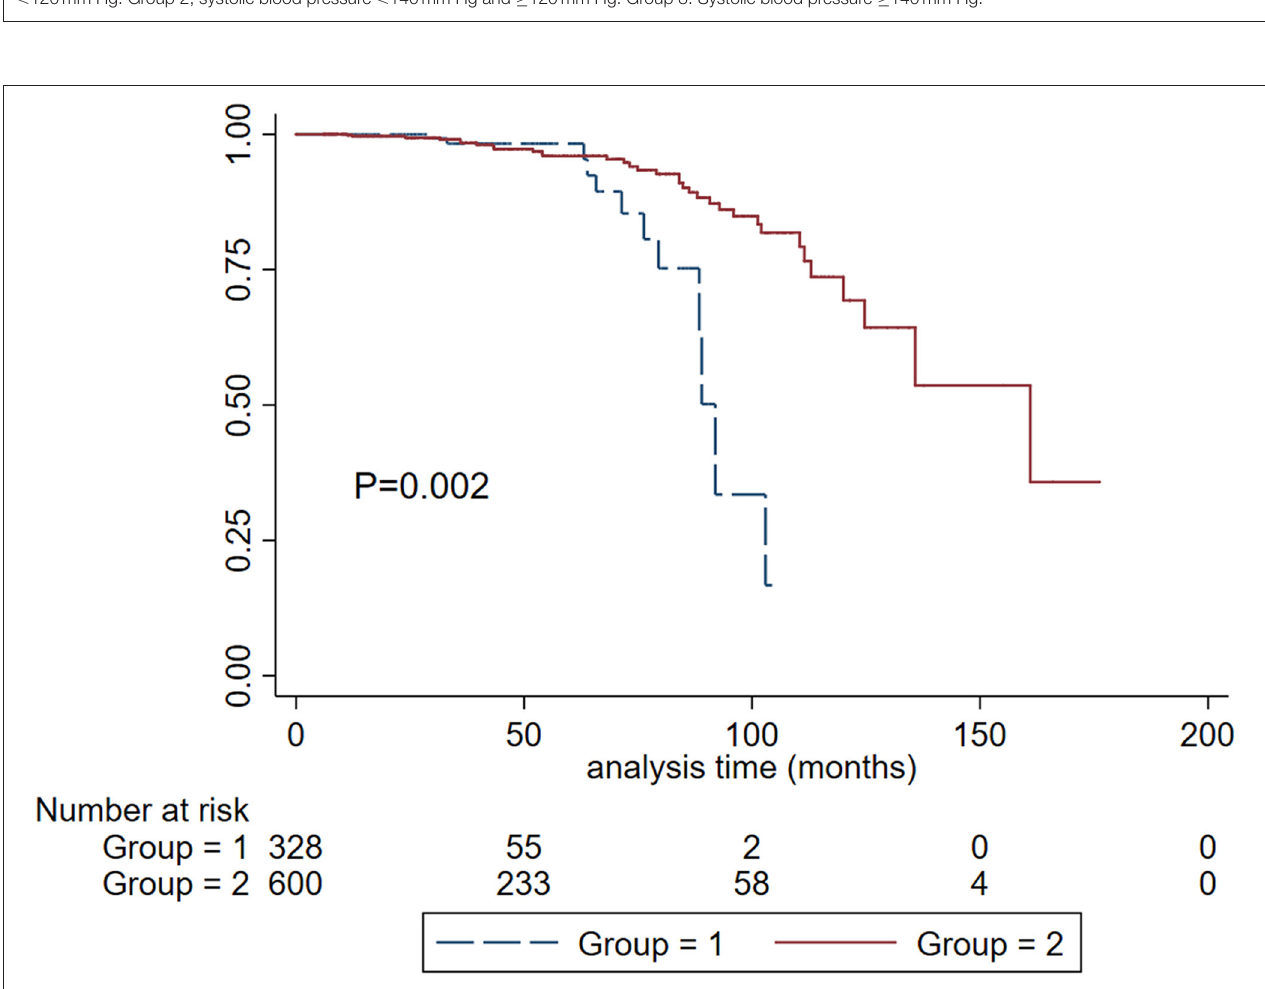
Frontiers in Medicine |